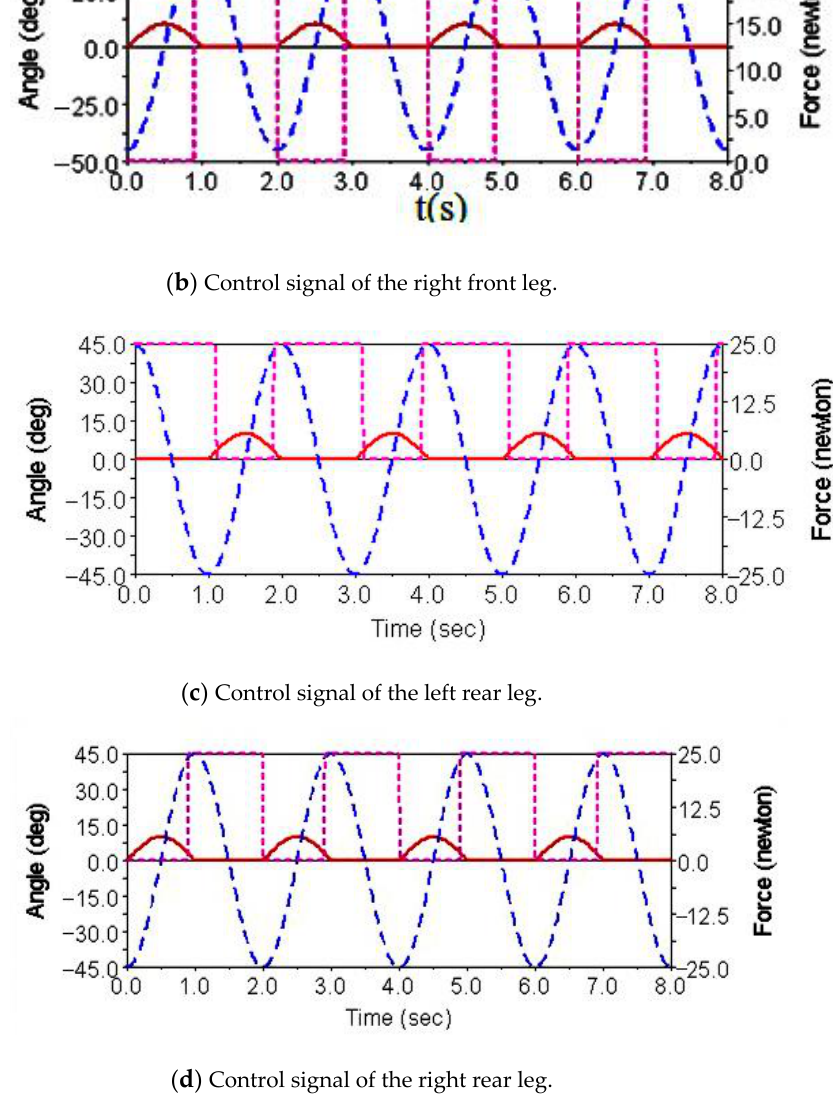
Figure 4. Robot leg control signals for diagonal gait and walking straight forward.